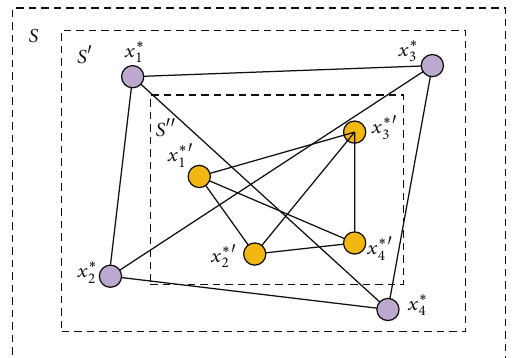
Figure 2: A case of